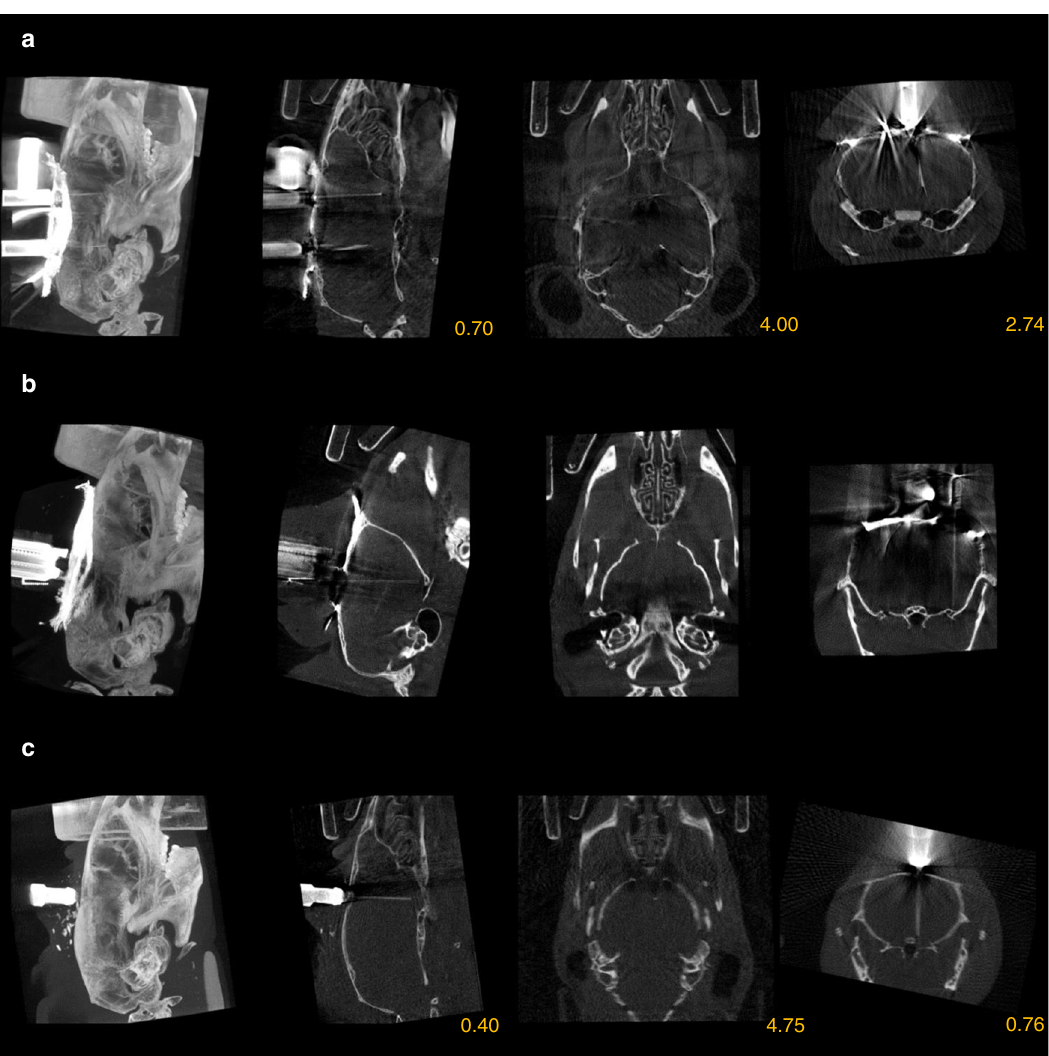
Fig. 3 Localization of multiple-targeting implants, silicon probes, and optic fi bers. a CT image of a dual-tetrode drive implanted in the HDB and the ventral tegmental area (VTA). b CT image of a single-shank Buzsaky-type silicon probe implanted in the ventral CA3. The image was rotated to visualize the thin silicon probe. c CT image of an optic fi ber implanted in the HDB. CT images are shown in grayscale. Images in each row from left to right, maximum intensity projection, sagittal slice, horizontal slice, and coronal slice. Yellow numbers refer to the corresponding stereotaxic coordinates in mm relative to Bregma (except for panel b , where the image was rotated for visualization